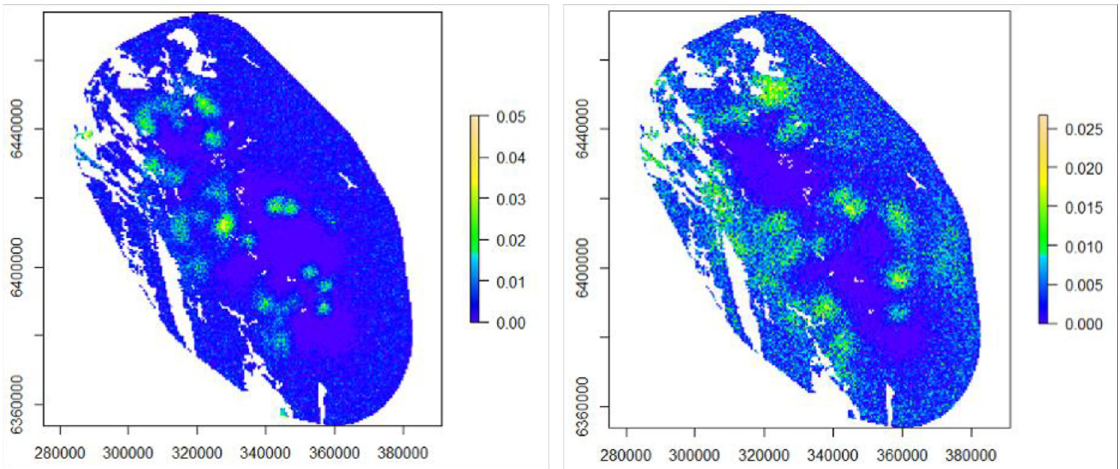
Fig 4. Expected density of individual leopards (individuals/km 2 ) predicted from the Bayesian SCR model, for summer (left) and winter